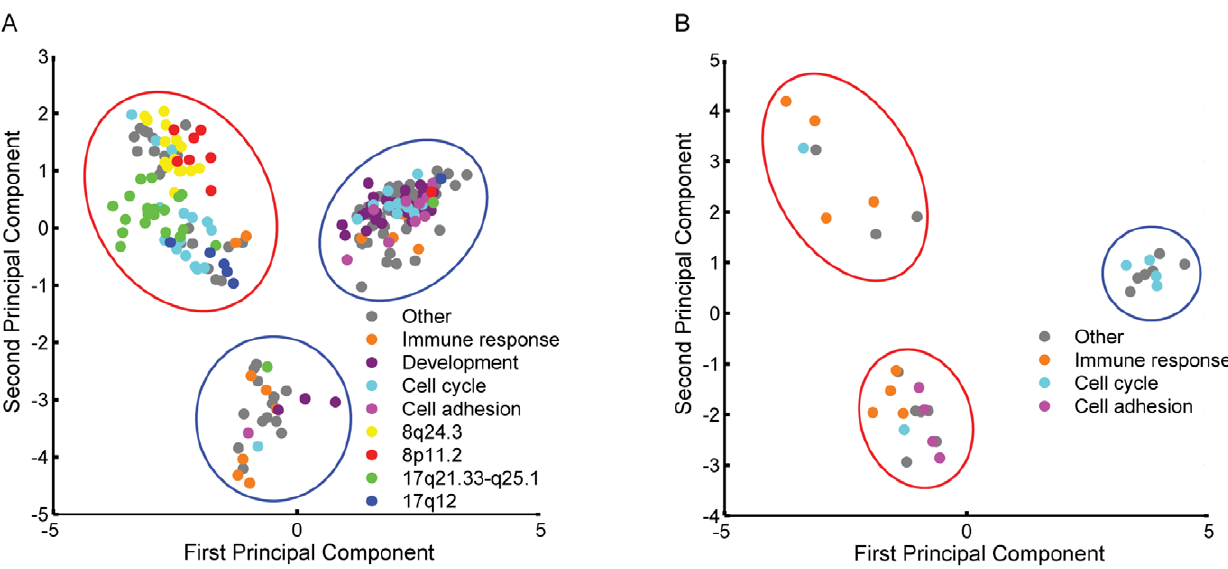
Figure 1. PCA plots of high and low outliers. Principal component analysis of high outlier genes (A) and low outlier genes (B) associated with differential distant metastasis free survival are shown. The figure represents the projection of each gene’s outlier profile on the first two principal components of the corresponding matrix. Gene clusters associated with good prognosis are circled in blue while gene clusters associated with bad prognosis are circled in red. Over-expressed genes associated with poor prognosis, which map to the chromosomal regions 8q24.3, 8p11.2, 17q21.33- q25.1 and 17q12, and are associated with specific GO pathways are labeled with different colors.